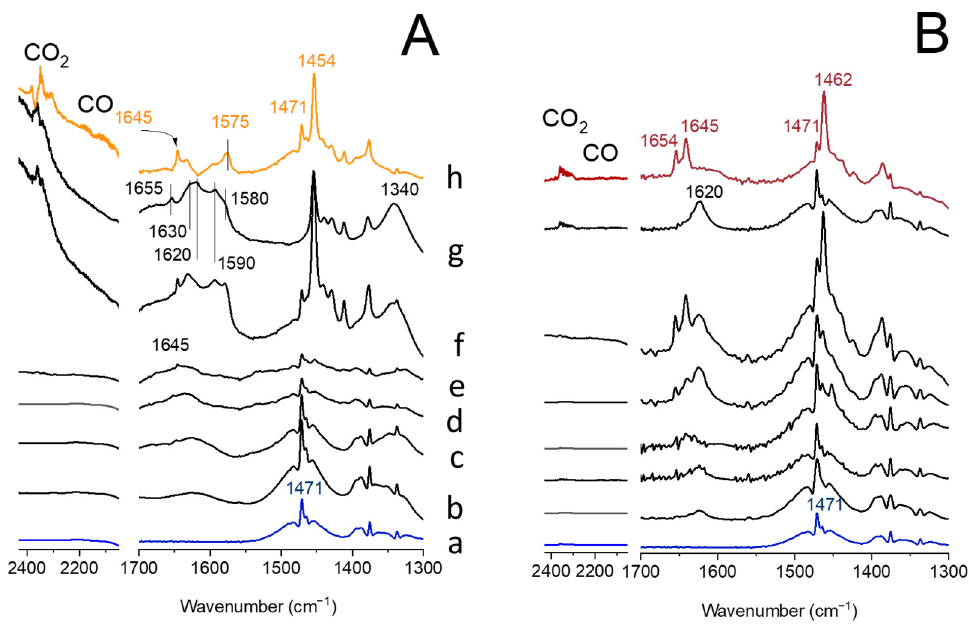
Figure 6. In situ FT-IR spectra collected during propane ODH process over V-HY ( A ) and V-HY deSi ( B ) presented in 2400–2050 cm − 1 (CO and CO 2 ) and 1700–1300 cm − 1 (surface adsorbed species) spectral ranges: gaseous propane at RT (a), propane on the catalyst at RT (b), propane and O 2 (c) at RT, (d) at 200 ◦ C, (e) at 350 ◦ C, (f) upon reaction at 350 ◦ C and cooled down to RT, (g) upon desorption at RT, and (h) the spectrum of gaseous species formed during process.